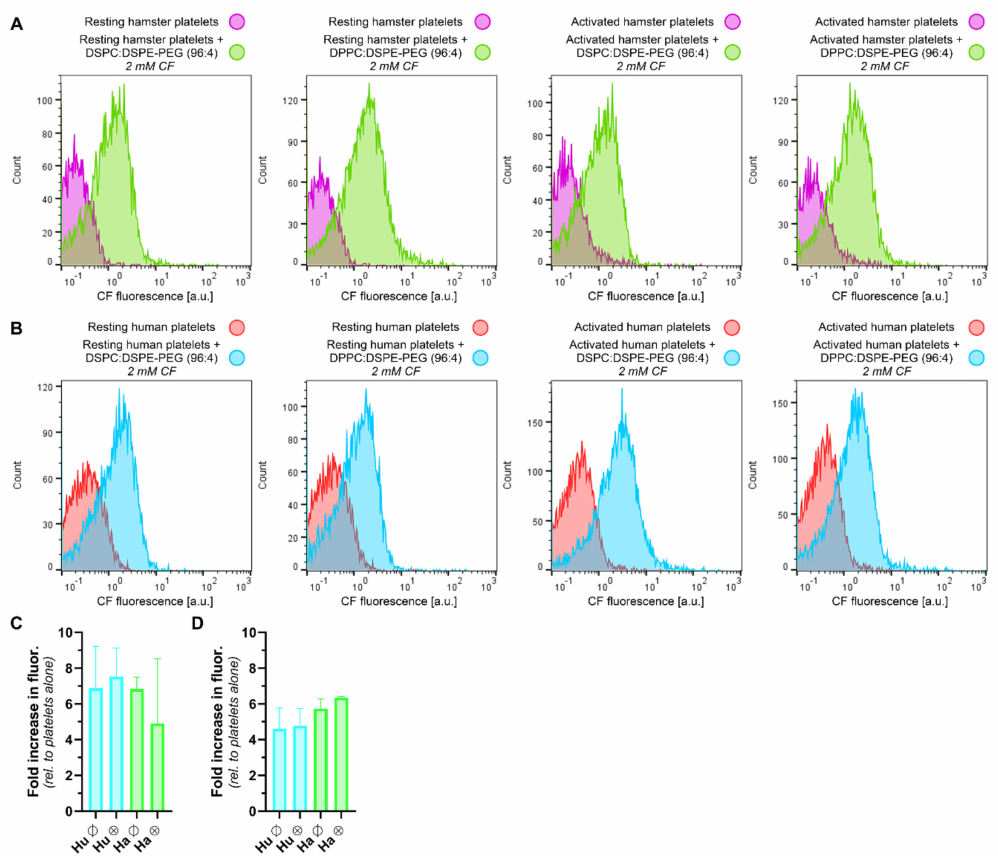
Figure 5. Representative flow cytograms of resting and convulxin-activated hamster ( A ) and human ( B ) platelets that had been incubated with 5(6)-carboxyfluorescein (CF)-encapsulating DSPC:DSPE-PEG (96:4) and DPPC:DSPE-PEG (96:4) LUVETs (N = 3–4 per group). The purple ( A ) and red traces ( B ) represent fluorescence histograms of platelets that had not been incubated with LUVETs (control). The green ( A ) and blue traces ( B ) represent fluorescence histograms of platelets that had been incubated with LUVETs. The fold increase in fluorescence relative to non-labeled platelets is provided in ( C ) for DSPC:DSPE-PEG (96:4) LUVETs and ( D ) for DPPC:DSPE-PEG (96:4) LUVETs (Hu, human; Ha, hamster; ∅ , resting platelets; ⊕ , activated